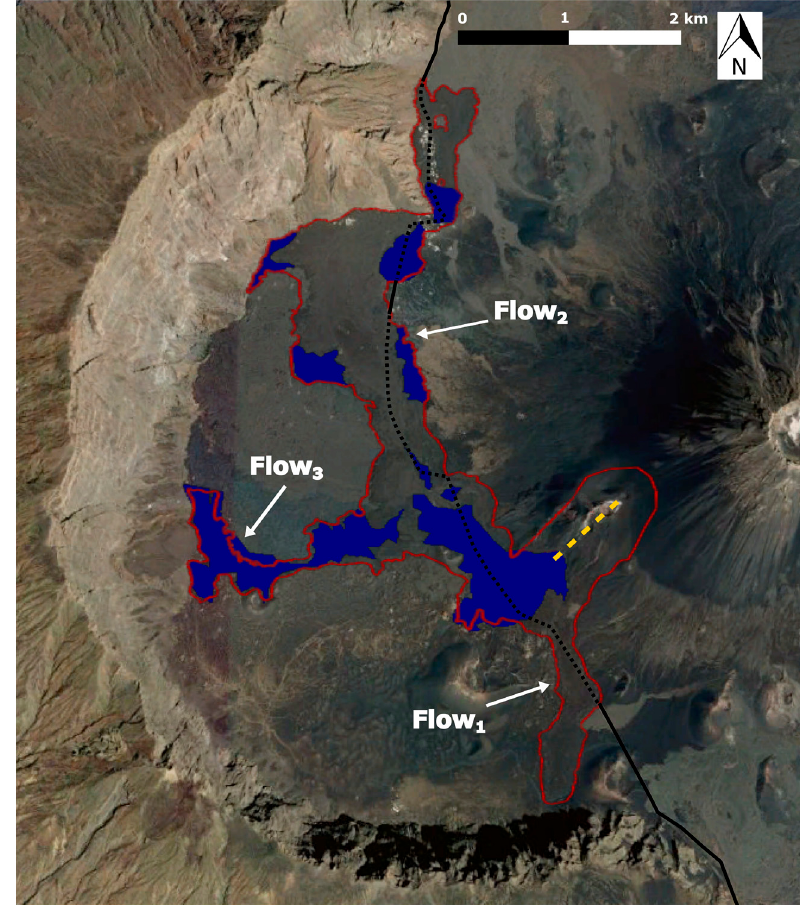
Figure 5. Map with outline of the whole lava flow field (red line) mainly comprising aa lava flow surfaces, with the blue area indicating the distribution of pahoehoe lava flows. See text for further explanation. Flow 1 made of aa (arterial flow volume-controlled); Flow 3 made of pahoehoe (secondary flow fed by drainage of Flow 2); and Flow 2 complex flow made of aa (initial arterial flow) + pahoehoe (at the flow margins, mainly by emptying of the flow interior) + proximal pahoehoe by late stage (degassed) flow emplacement. The yellow dotted line indicates the eruptive fissure, the black line the access road to Cha Caldera (dotted where covered by the lava flows).